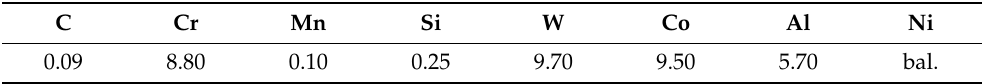
Table 1. Chemical composition of MAR 247 nickel based superalloy